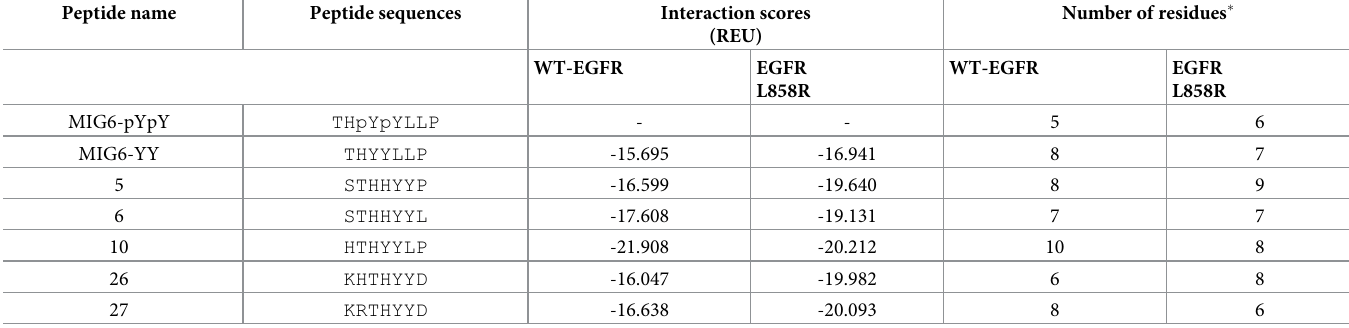
Table 1. Computational modeling interaction scores and predicted interaction results of top scoring poses of docked peptides with WT-EGFR and EGFRL858R (PDB: 4ZJV, 4R3R).